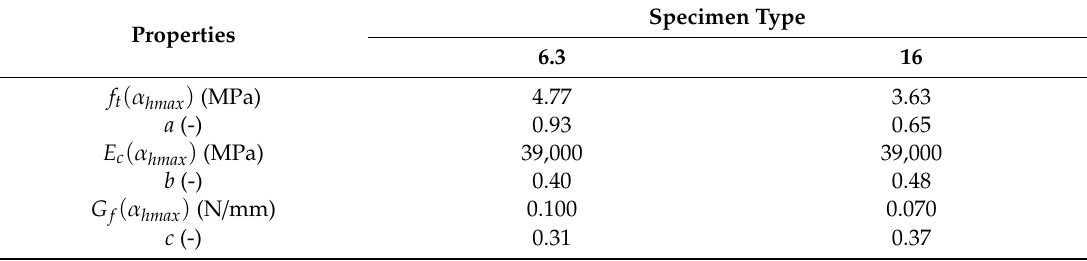
Table 4. Regression coe ffi cients of degree of hydration based early age concrete fracture